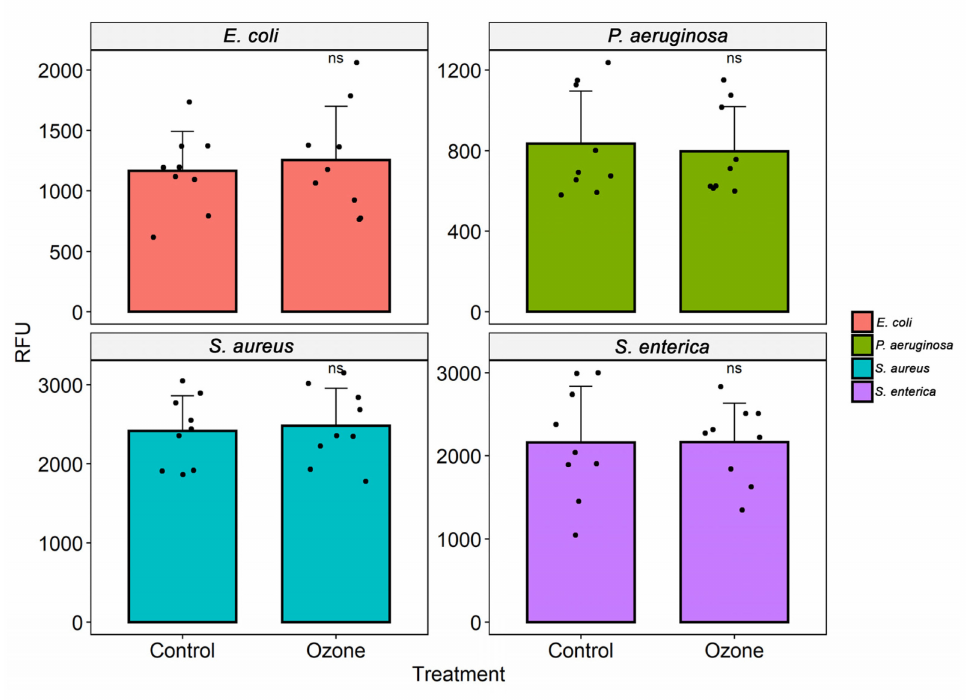
Figure 3. Analysis of cell viability after ozone treatment in different bacterial strains ( S. aureus (ATCC 6538), S. enterica (ATCC 10708), E. coli (ATCC 25922), and P. aeruginosa (ATCC 15442)). The measurement of fluorescence intensity (relative fluorescence units, RFU) after the conversion of resazurin to resofurin by viable bacteria was performed in the control group (no treatment) and bacterial suspensions (10 5 CFU/mL) after exposure to ozone for 40 min. Results represent values from 3 randomly chosen colonies in the control group (no treatment) and after treatment with ozone. The black dots represent the values of fluorescence emission after addition of